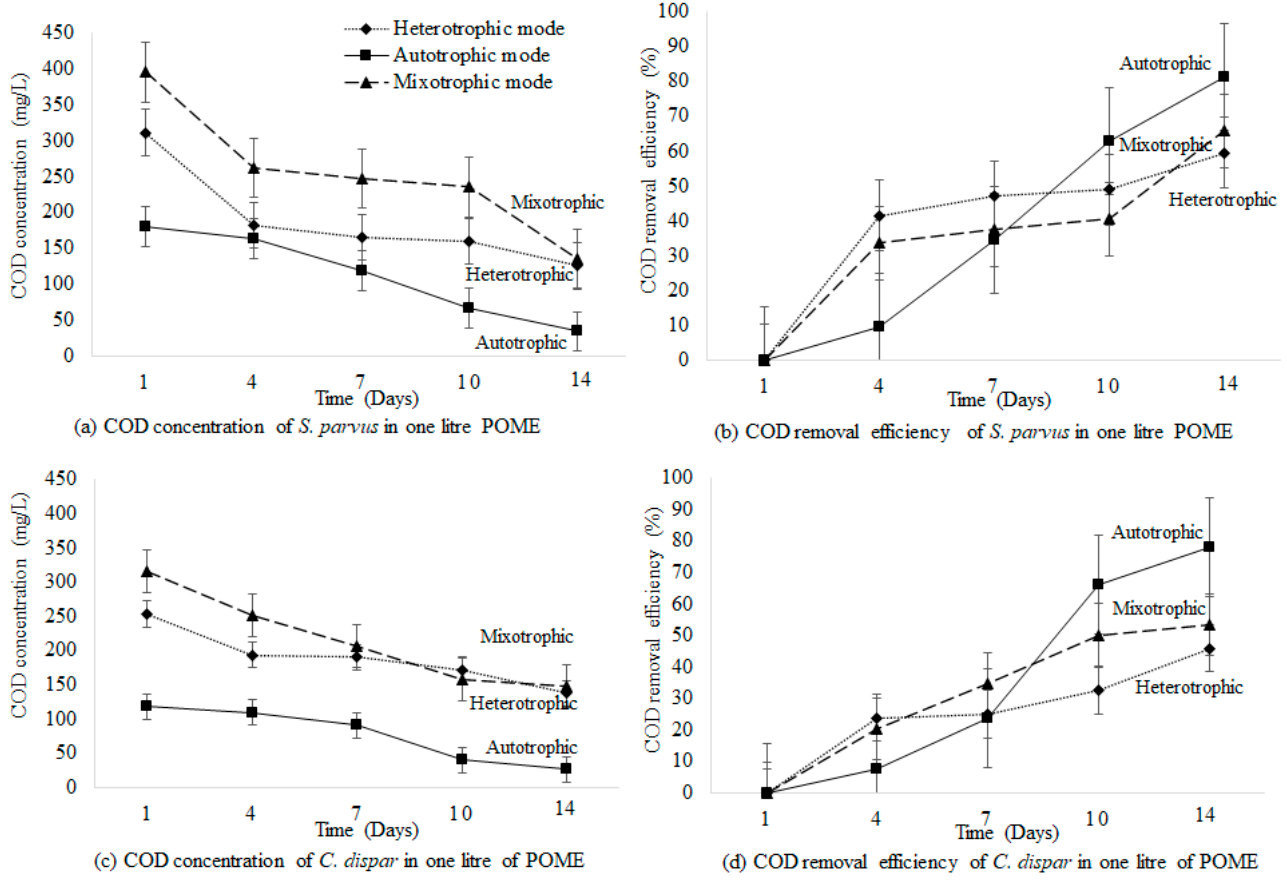
Figure 4. COD concentration and removal efficiency of ( a , b ) S. parvus and ( c , d ) C. dispar throughout the 14-day period of cultivation with 1 L of POME.